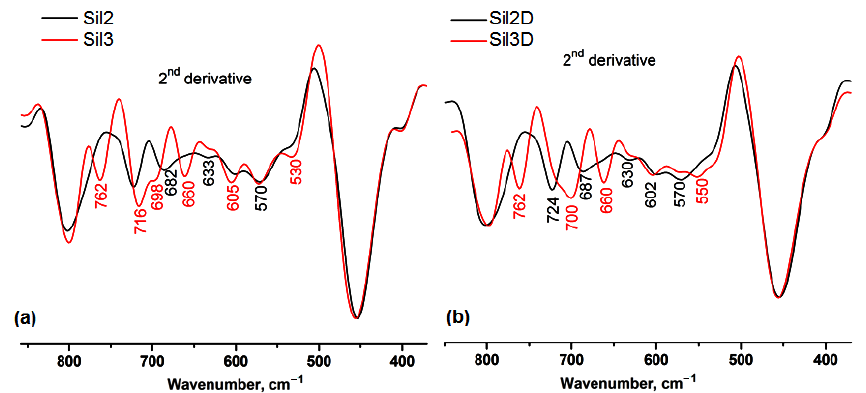
Figure 6. Second derivative of the IR spectra of Sil2, Sil 3 ( a ) and Sil2D, Sil3D, with Dox encapsulated ( b ) in the 850–400 cm −1 spectral range.